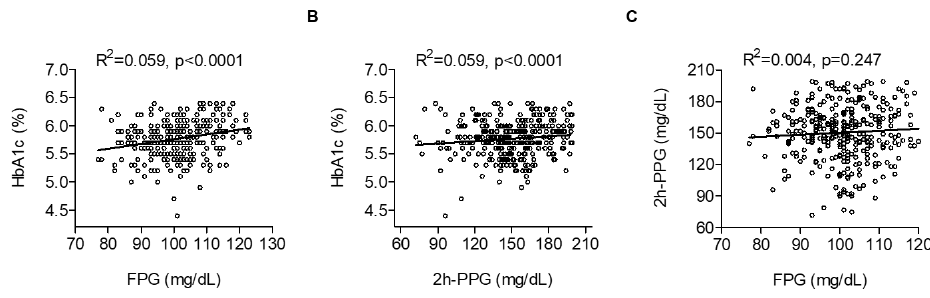
Figure 2. Correlation among ( A ) FPG, ( B ) 2h-PPG and HbA1c, and ( C ) FPG and 2h-PPG.